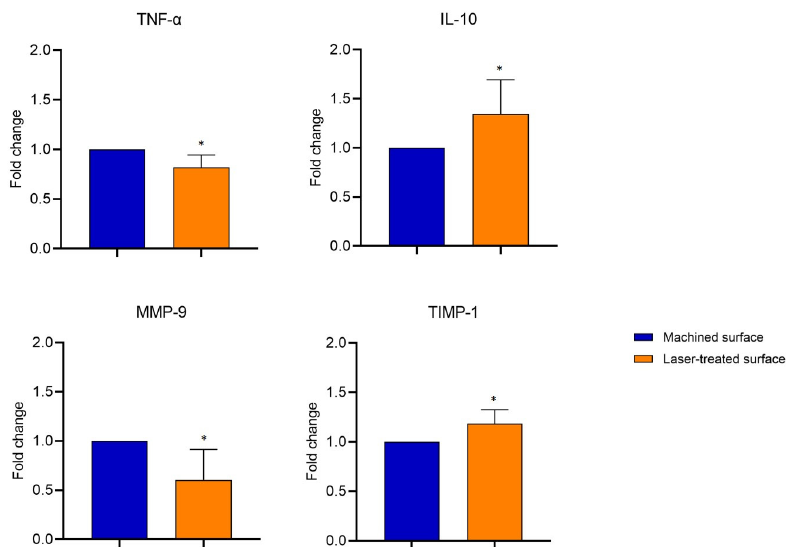
Figure 2. mRNA expression of MMP-9, TIMP1 , TNF- α , and IL-10 in soft tissue facing the laser-treated or machined surface by qPCR. Fold changes were determined from the - ΔΔ Ct values, calculated using 18S as reference gene and normalized to the machined-surface, as the control condition. Values are expressed as mean ±SD of 15 different specimens.* indicates values statistically different ( p < 0.05) between machined- and laser-treated surfaces.